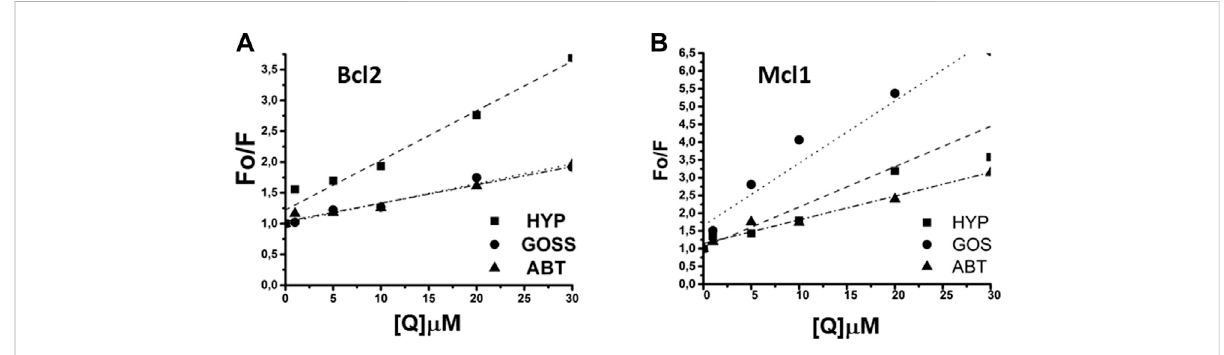
FIGURE 5 Thelinear fi tofStern-VolmercurvesforBcl2andMcl1proteins. (A) Thelinear fi tforBcl2and (B) forMcl1proteininteractionwithHyp,Gossypol, and ABT263.